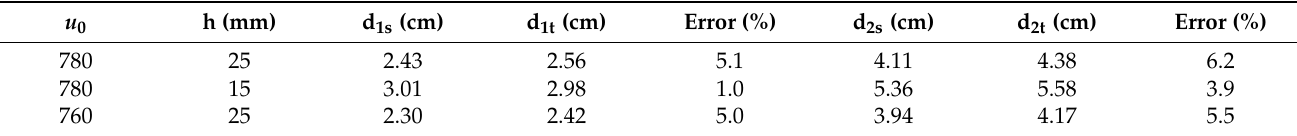
Table 5. Numerical simulation results and test results.